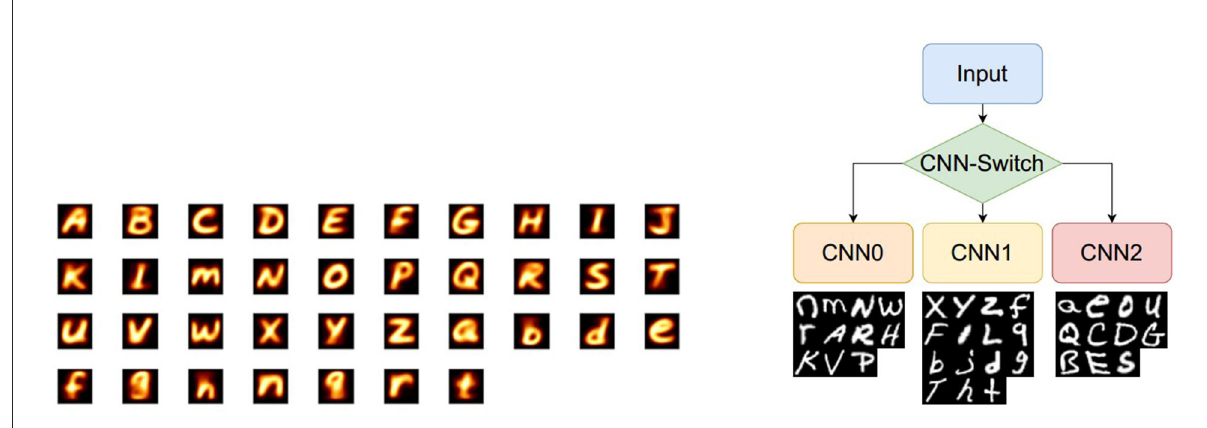
FIGURE10 Letters from the EMNIST dataset and their three categories. (Left) The visualization of the average value for each letter from the EMNIST dataset. As can be seen, several classes share lots of similarities to some degree, such as I and L , f and F , h and n , g and q , and Q and a which makes this classification task challenging. (Right) CNN tree architecture using dynamic model swapping on SCAMP in which each CNN performs comparatively simpler tasks using the 4-layer CNN. These 4 categories using EMNIST merged classes.